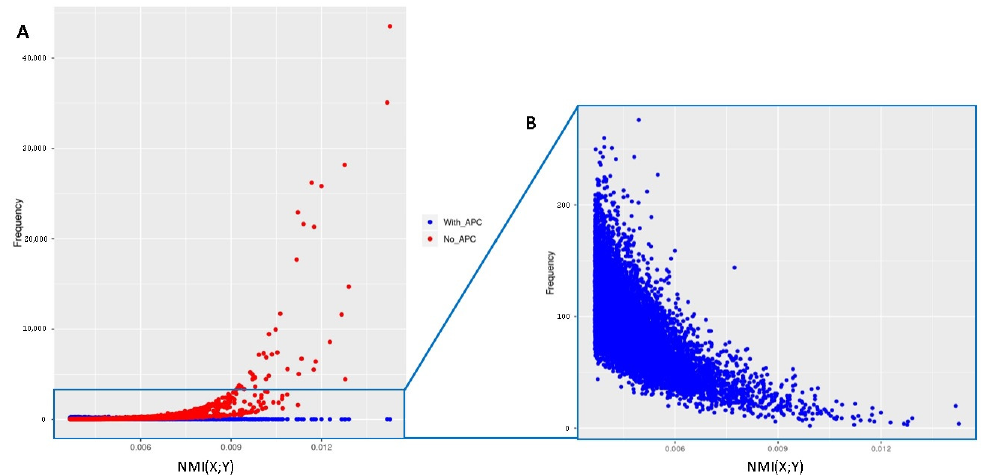
Figure 6. ( A ) shows the distribution of the SNP frequency and their association to the phenotype. The blue and red points stand for the frequency of the SNPs based on with and without the application of the APC, respectively. ( B ) only shows the frequencies for the interactions with APC.